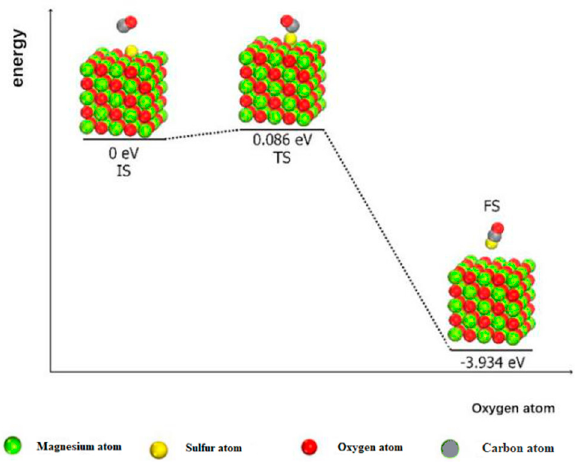
Figure 8. Energy line diagram of MgO (100) surface reduced by CO.